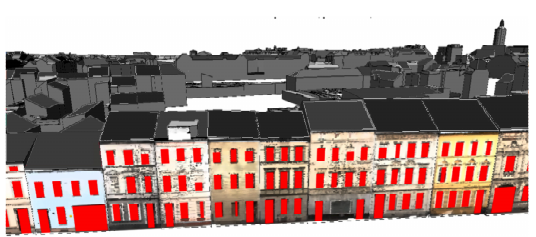
Figure 1. Facades in a terrestrial laser scanning point cloud (left) vs. facades in a photogrammetric point cloud (right)